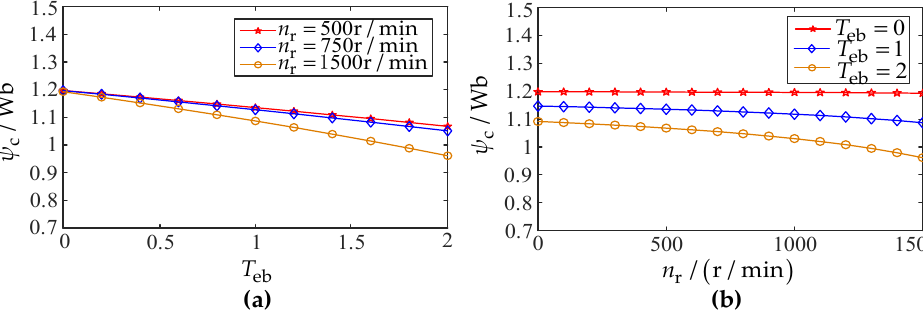
Figure 10. Specific numerical calculation results of MTPA control. ( a ) The change of the rotor flux